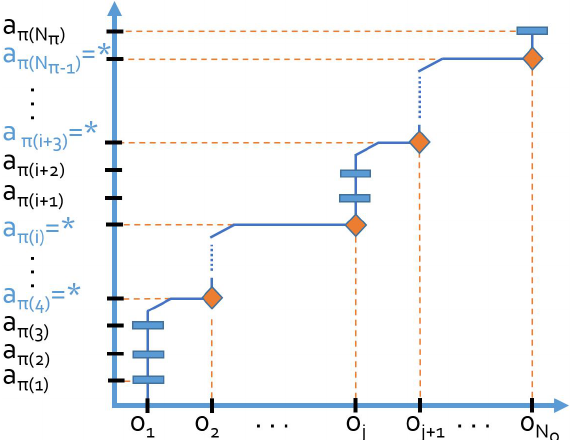
Figure 3. Illustration of the sequencing method. The activities are separated into the different groups of activities that are assigned to different operators.